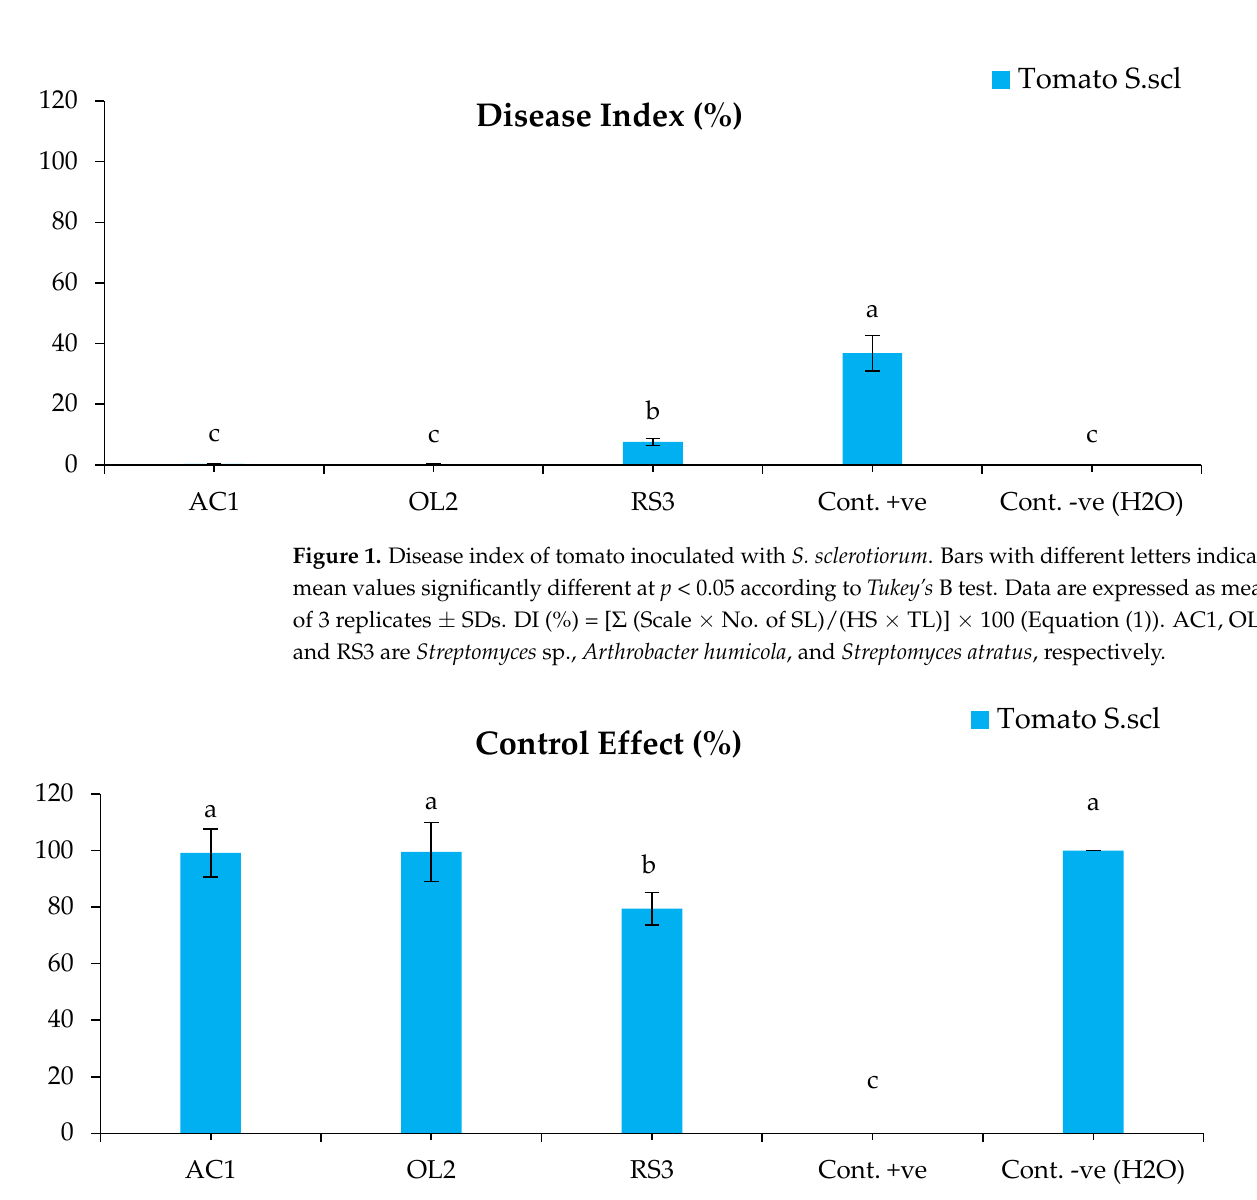
Figure 2. Control effect of the tomato inoculated with S. sclerotiorum . Bars with different letters indicate mean values significantly different at p < 0.05 according to Tukey’s test. Data are expressed as mean of 3 replicates ± SDs. CE (%) = 100 × (DI-P-DI-B)/DI-P (Equation (2)).